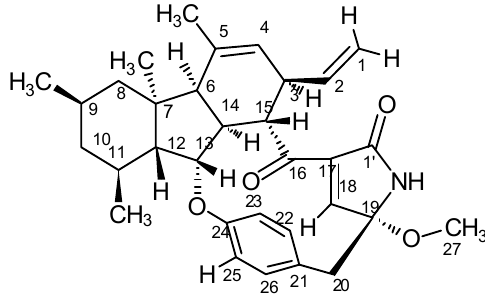
Figure 1. The relative configuration of D1399.